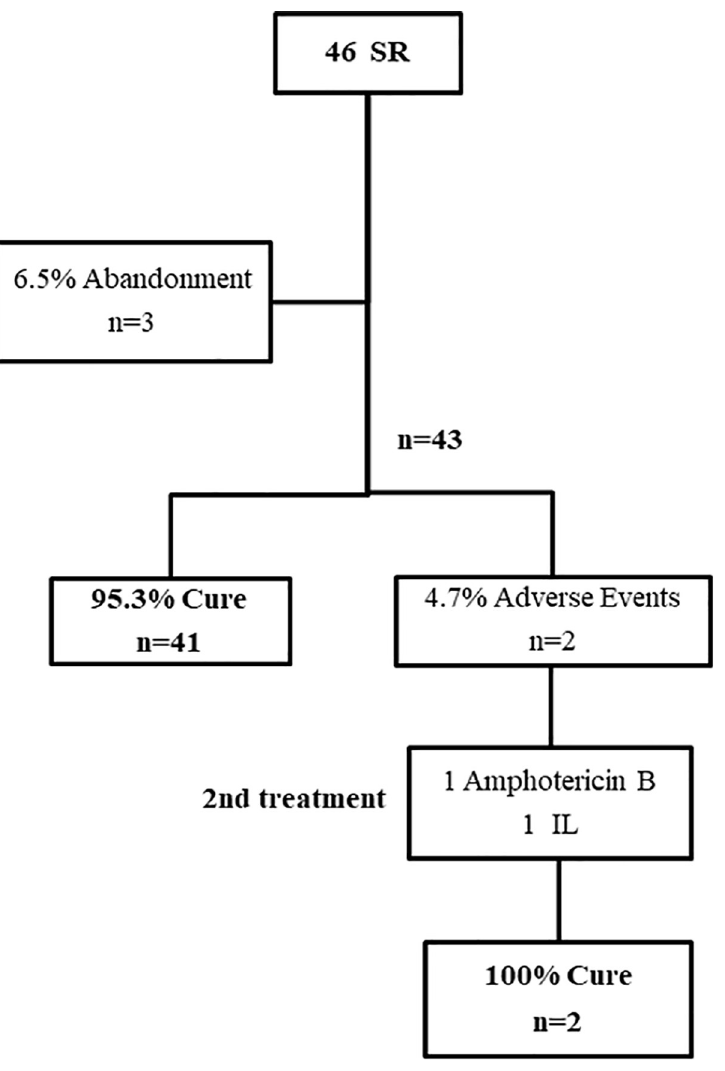
Fig 2. Patients follow-up: standard regimen group. SR- standard regimen; IL- intralesional